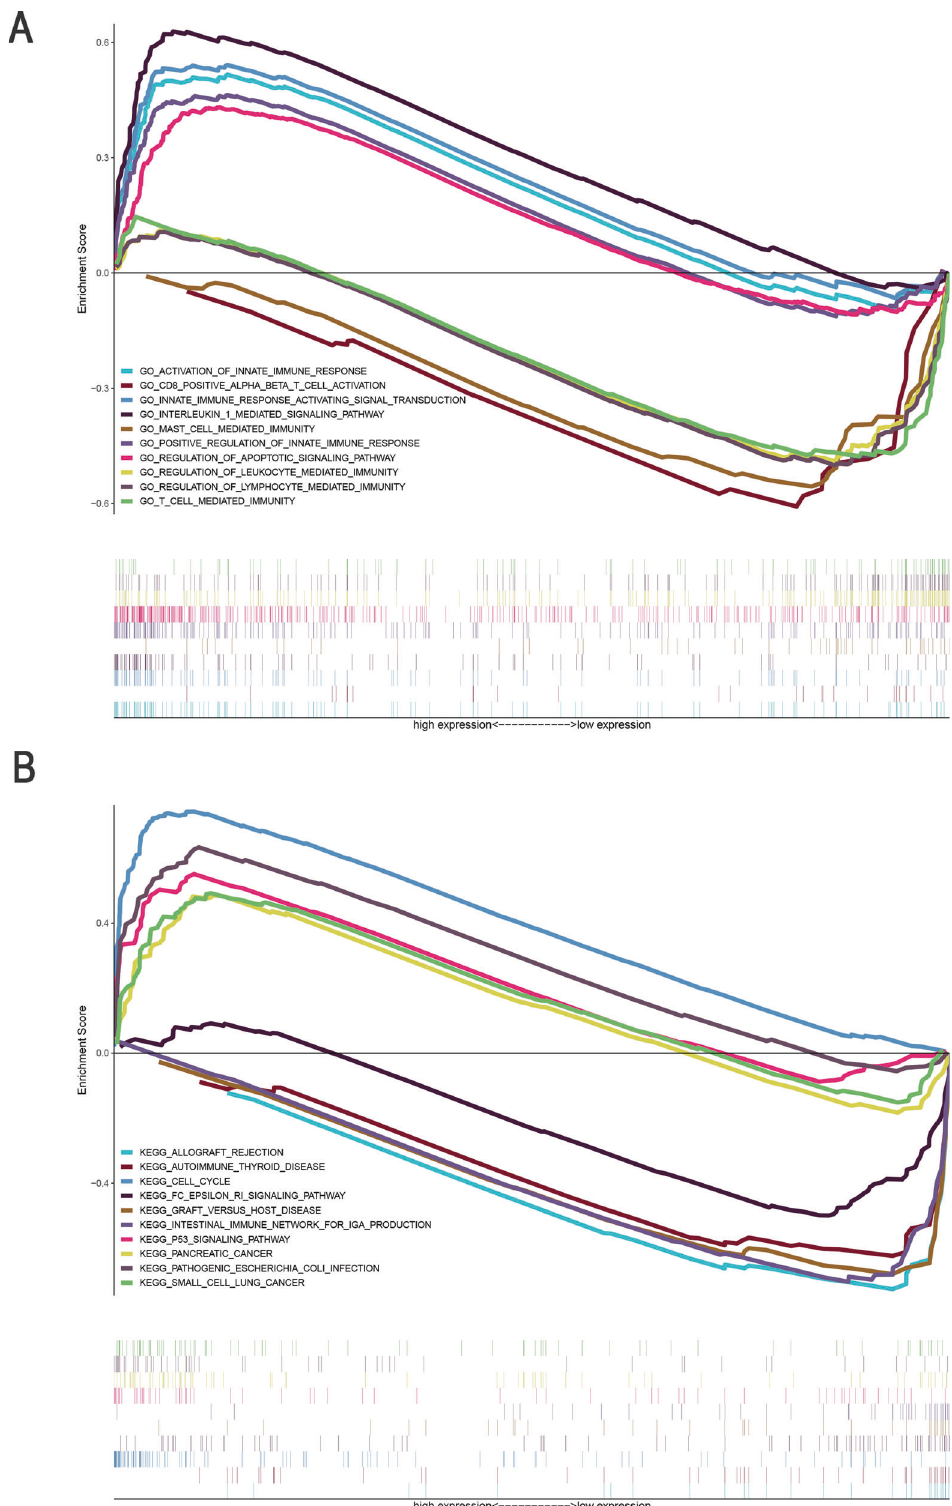
Ferroptosis is a novel iron-dependent and nonapoptotic form of cell death that is mediated by oxidative modi fi cations of membrane polyunsaturated phospholipids. As an adaptive mechanism to eliminate malignant cells, ferroptosis is a